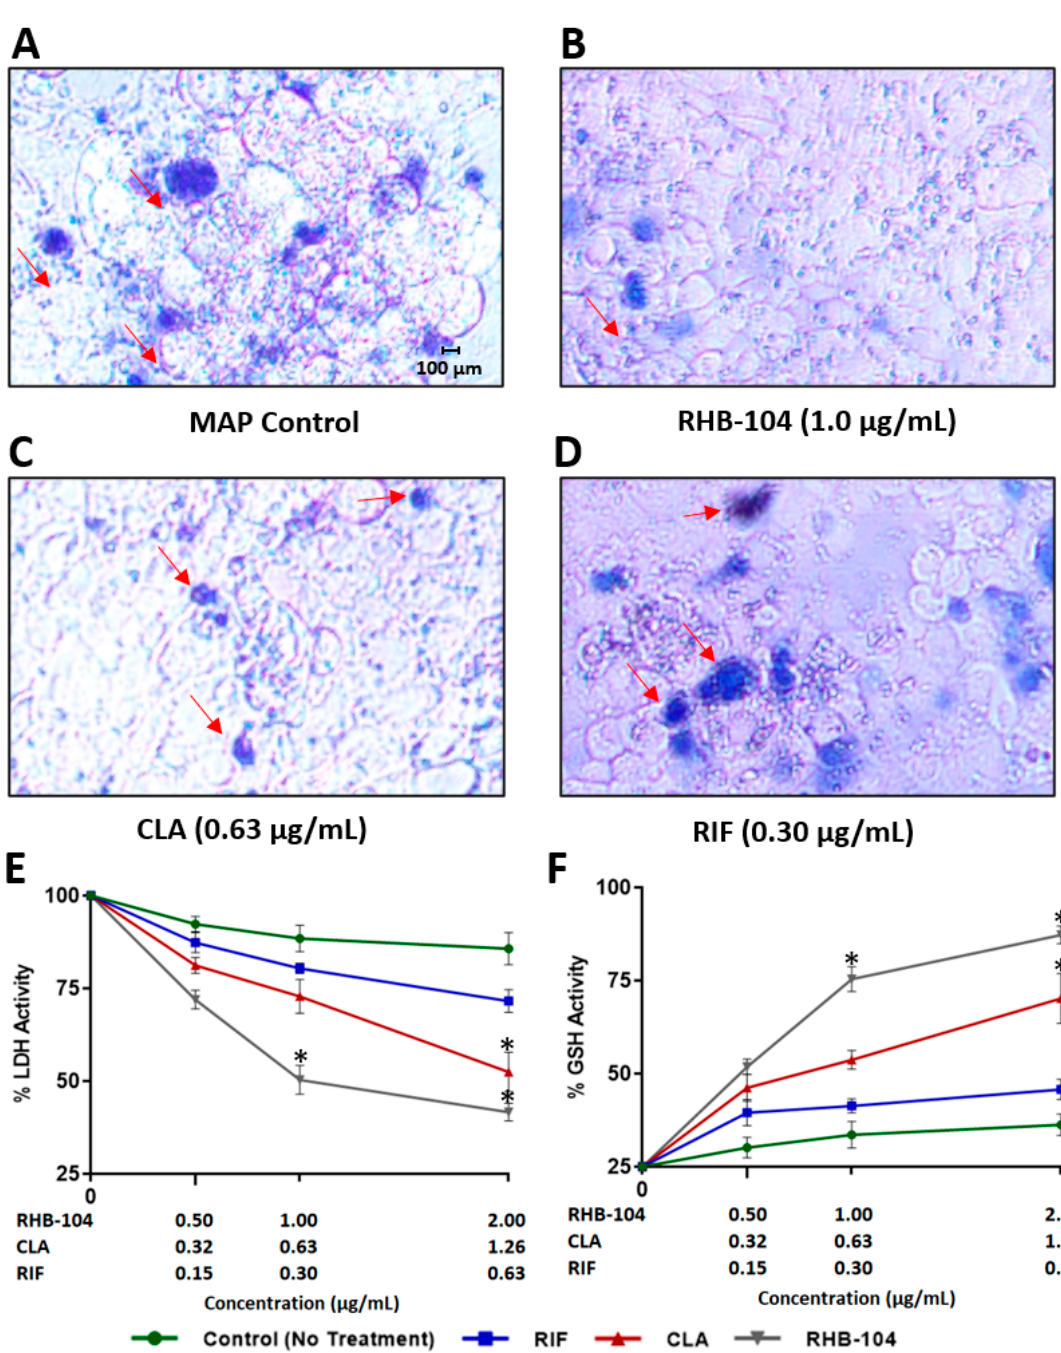
Figure 6. Anti-cytotoxic activity of RHB-104 and its major components in Caco-2 monolayers infected with MAP. Trypan blue exclusion assay showing the cytotoxic e ff ects (indicated by red arrows) in MAP-infected Caco-2 monolayers ( A ), and MAP-infected Caco-2 monolayers treated with 1.0 µ g / mL RHB-104 ( B ), 0.63 µ g / mL CLA ( C ), and 0.30 µ g / mL RIF ( D ). LDH Activity ( E ) and GSH Activity ( F ) in MAP-infected Caco-2 monolayers treated with RHB-104 (0, 0.5, 1.0, 2.0 µ g / mL), CLA (0, 0.32, 0.63, and 1.26 µ g / mL), and RIF (0, 0.15, 0.30, 0.60 µ g / mL) for 24 h. * p < 0.05.